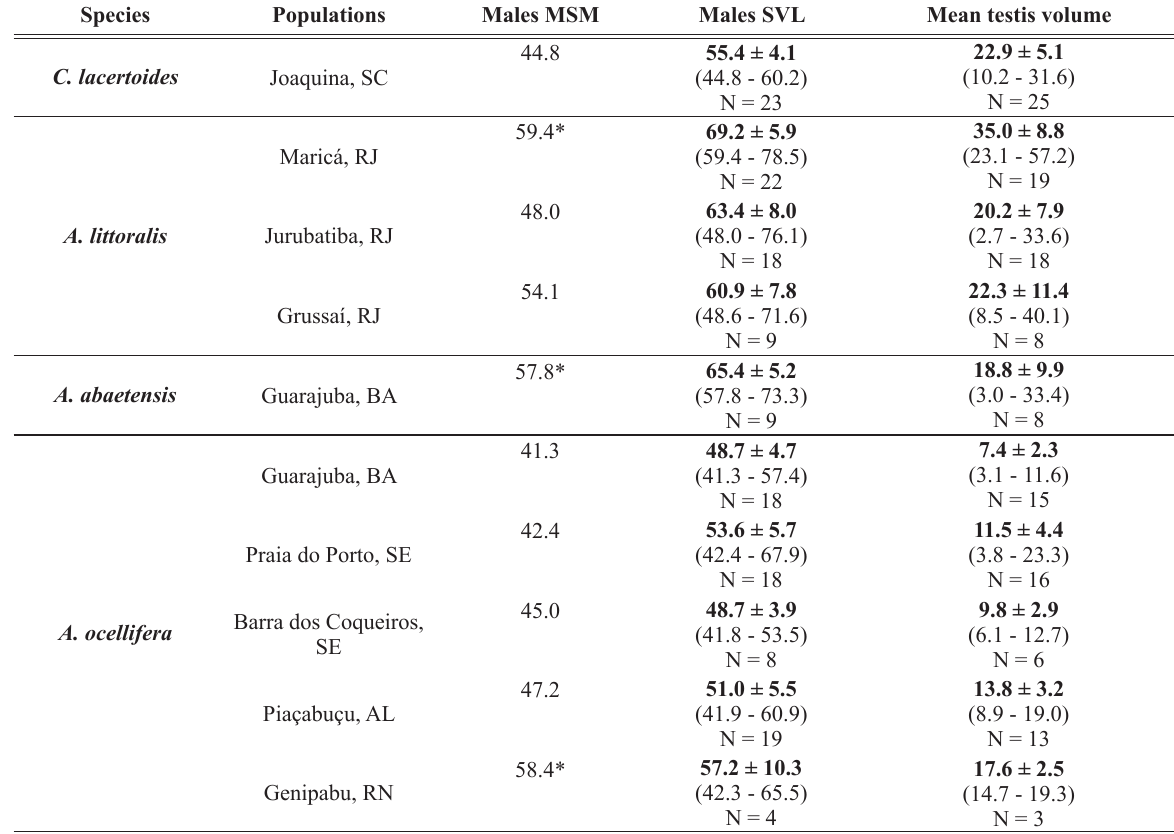
Figure 6 - Minimum size at maturity (MSM, in mm), mean snout-vent length (SVL, in mm) and mean testis volume (mm 3 ) of males of different species and populations of Ameivula and Contomastix along the eastern coast of Brazil. Values are represented by arithmetic mean + one standard deviation with the range in parentheses and sample size below. State codes: SC -